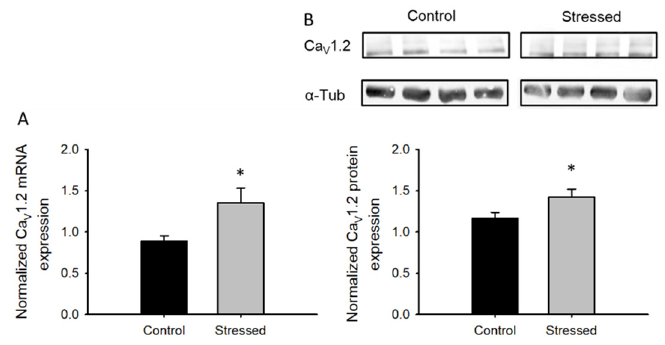
Figure 3. Chronic stress promotes the expression of Ca V 1.2 subunit in whole hippocampal samples: ( A ) Bar graph of semi-quantitative PCR expression for the Ca V 1.2 mRNA, normalized to 18S mRNA, isolated from whole hippocampus of juvenile rat controls ( n = 8) or subjected to CRS for 3 weeks ( n = 8). ( B ) Bar graph of Ca V 1.2 protein expression from whole hippocampus lysates normalized to α - tubulin ( n = 8), in the upper part, a representative immunoblots showing Ca V 1.2 and α -tubulin protein expression is shown. Bar graphs are mean ± SEM; black bars are control animals, and gray bars correspond to CRS-subjected animals * p value < 0.05.